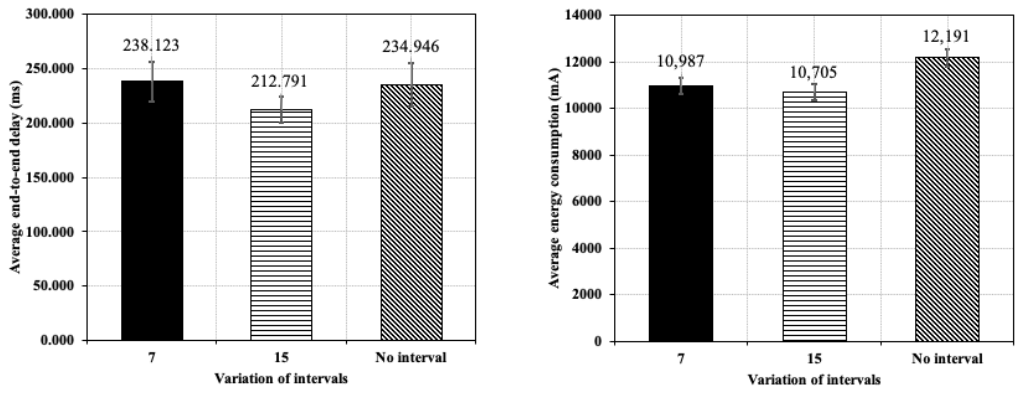
Figure 13. Average end-to-end delay for critical application (Instance 20) and average energy